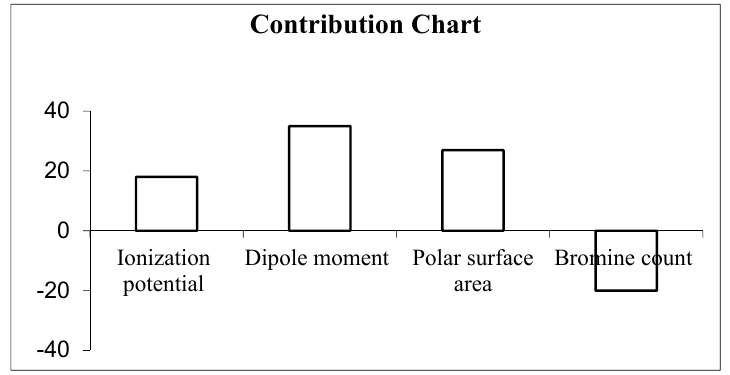
Figure 1. Contribution chart of descriptors in 2D QSAR model.